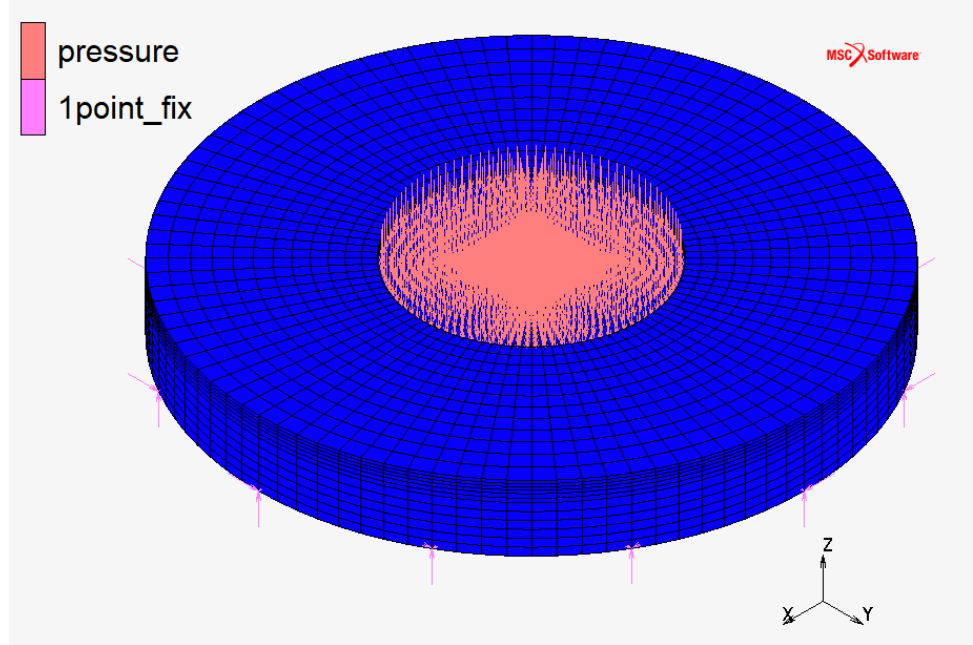
Figure 4. Monopolar plate—discretized domain in configuration “c”: circular plan view and circular active